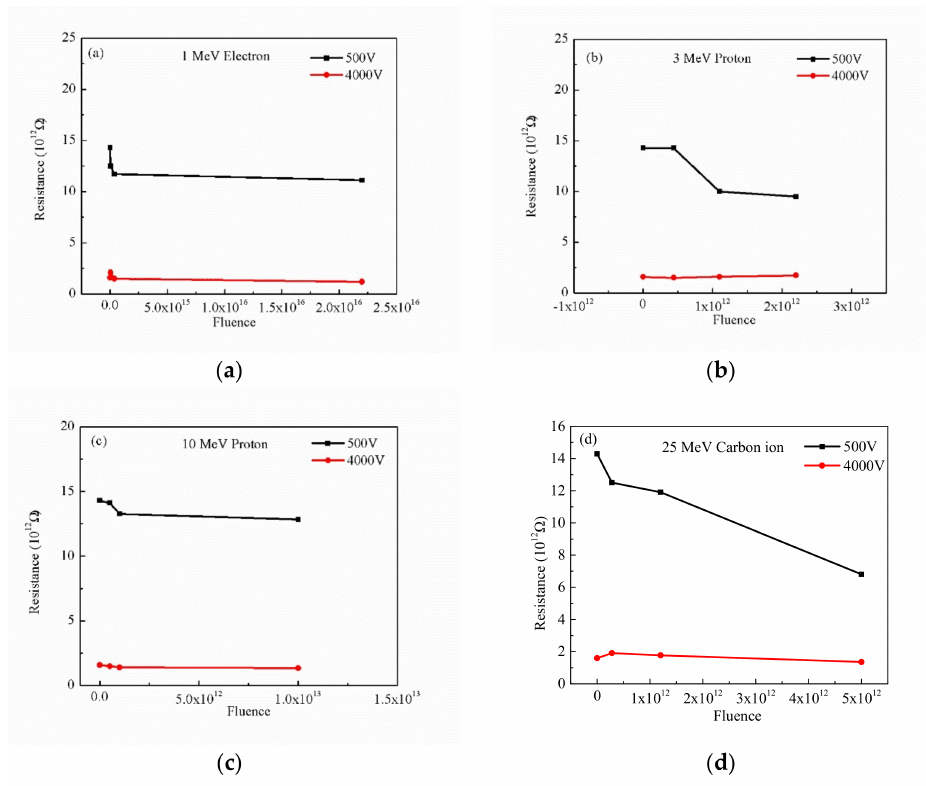
Figure 3. Frequency dependent resistance of pristine and irradiated PI films with di ff erent sources and fluences at room temperature: ( a ) 1 MeV electron, ( b ) 3 MeV proton, ( c ) 10 MeV proton, and ( d ) 25 MeV carbon